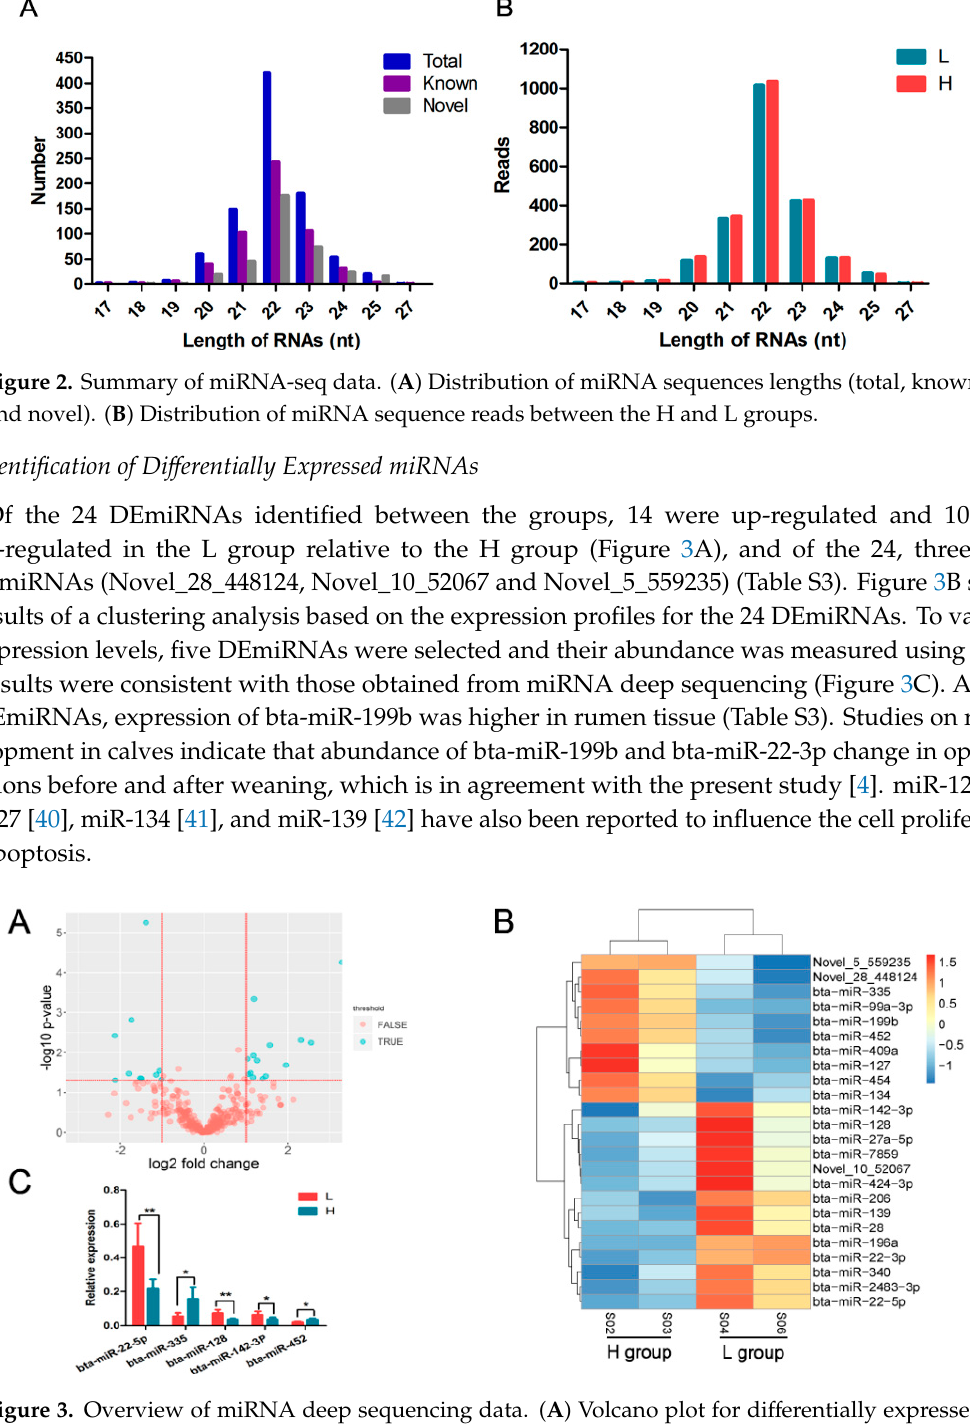
Figure 3. Overview of miRNA deep sequencing data. ( A ) Volcano plot for differentially expressed miRNAs. ( B ) Heatmap plot for relative expression abundance of DEmiRNAs. ( C ) Validation of DEmiRNAs by qPCR.